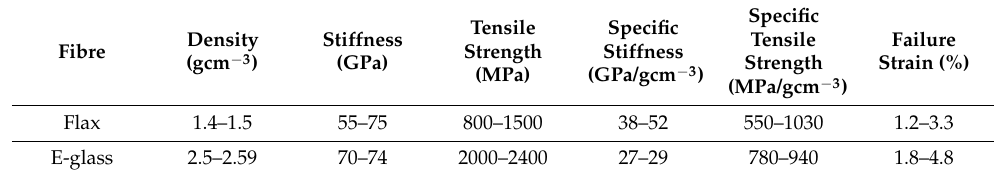
Table 3. Mechanical properties of flax and E-glass fibres